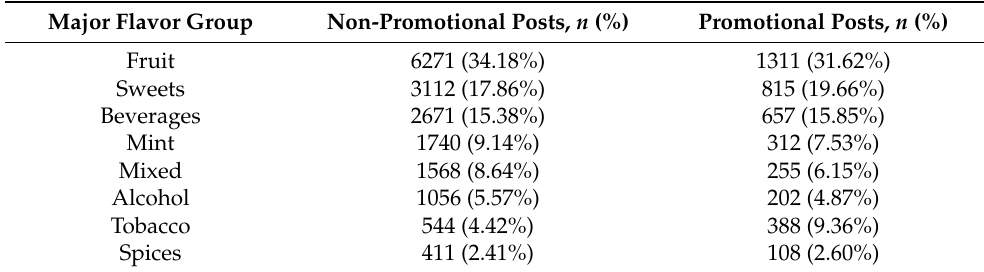
Table 1. Waterpipe flavors mentioned on Twitter 1 .